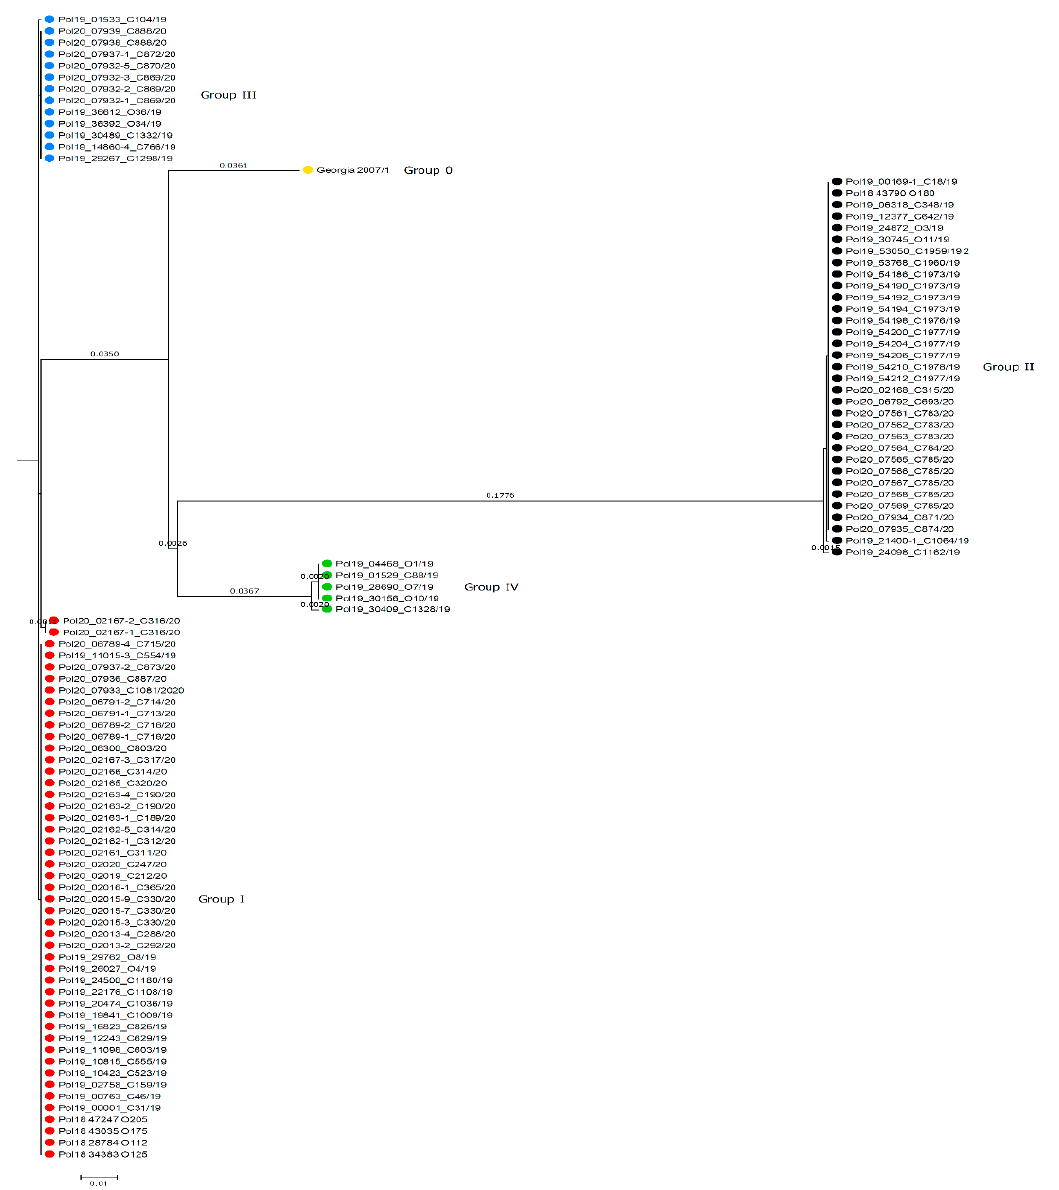
Figure 5. UPGMA phylogenetic tree constructed based on concatenated O174L , K145R and IGR I73R / I329L genomic regions sequences of ASFV present in Poland. Four main genetic groups (I–IV) are distinguished in Poland; the Georgia 2007 / 1 reference strain sequence formed a separate branch, representing group 0. Color of dot for each group corresponds to the group color on the map in Figure 1D. The scale bar indicates nucleotide substitutions per site.